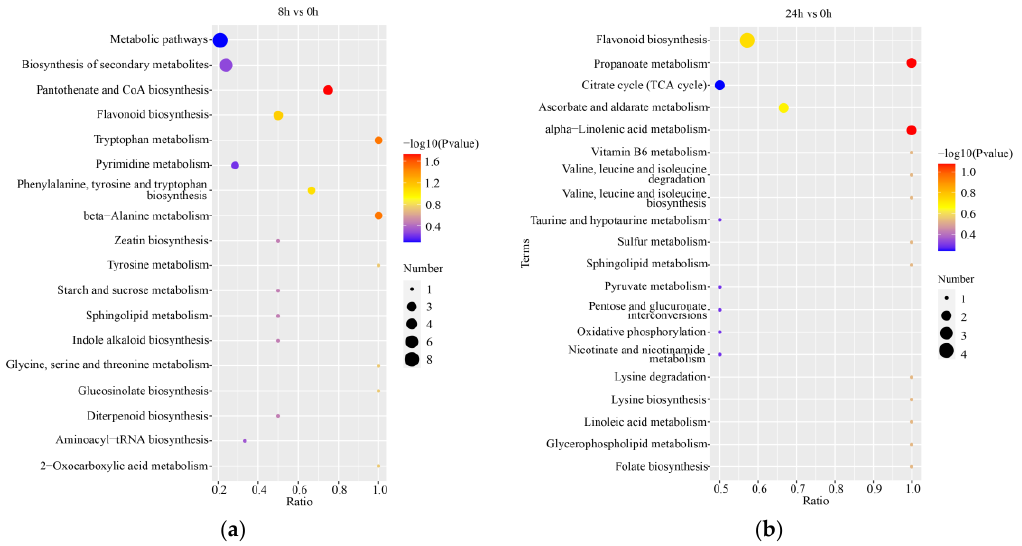
Figure 6. Functional enrichment and correlation analysis of differentially expressed metabolites (DEMs) in the roots of orchardgrass under submergence stress. Bubble diagram of T20 enrichment pathway in 8 h vs. 0 h ( a ) and 24 h vs. 0 h ( b ).